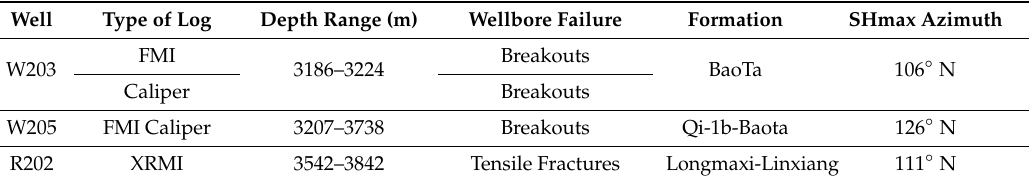
Table 4. Summary of image analysis.